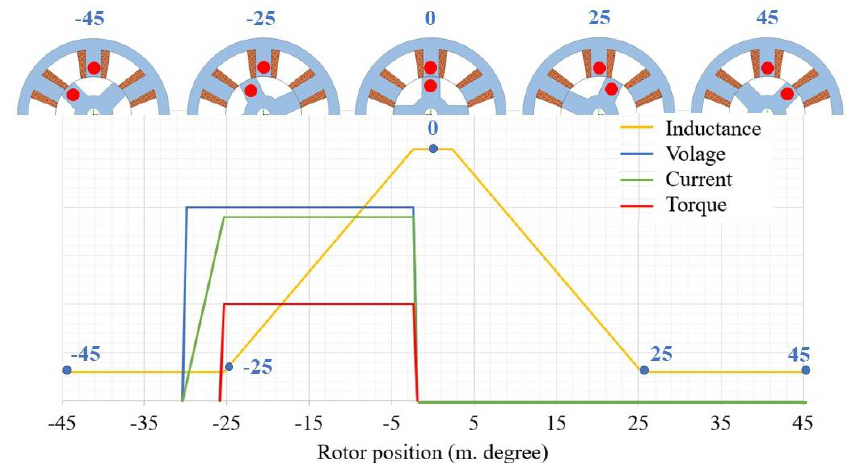
Figure 3. Ideal inductance profile of one SRM phase.